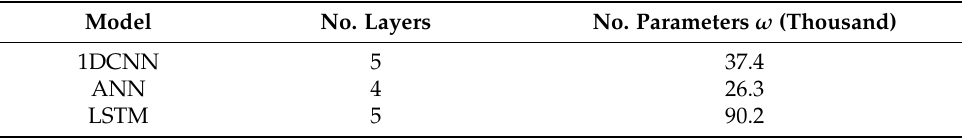
Table 3. The complexity of the proposed models using symptom data.